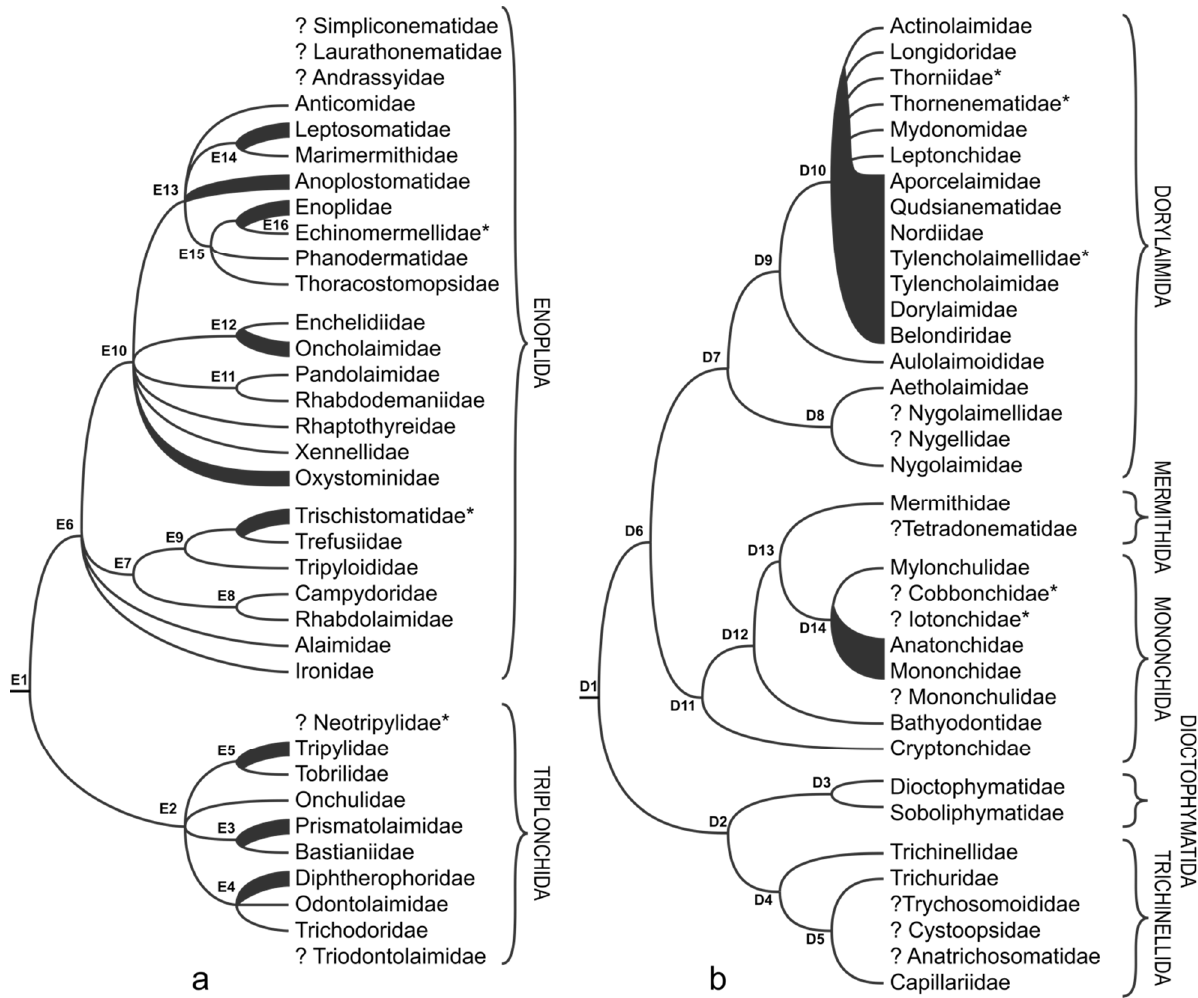
Figure 2. Overview of phylogenetic relationships within: ( a ) Enoplia; ( b ) Dorylaimia. Taxa marked with “*”were not included in the classification of De Ley and Blaxter [2,3]; “?” indicates taxa not included in molecular phylogenies.